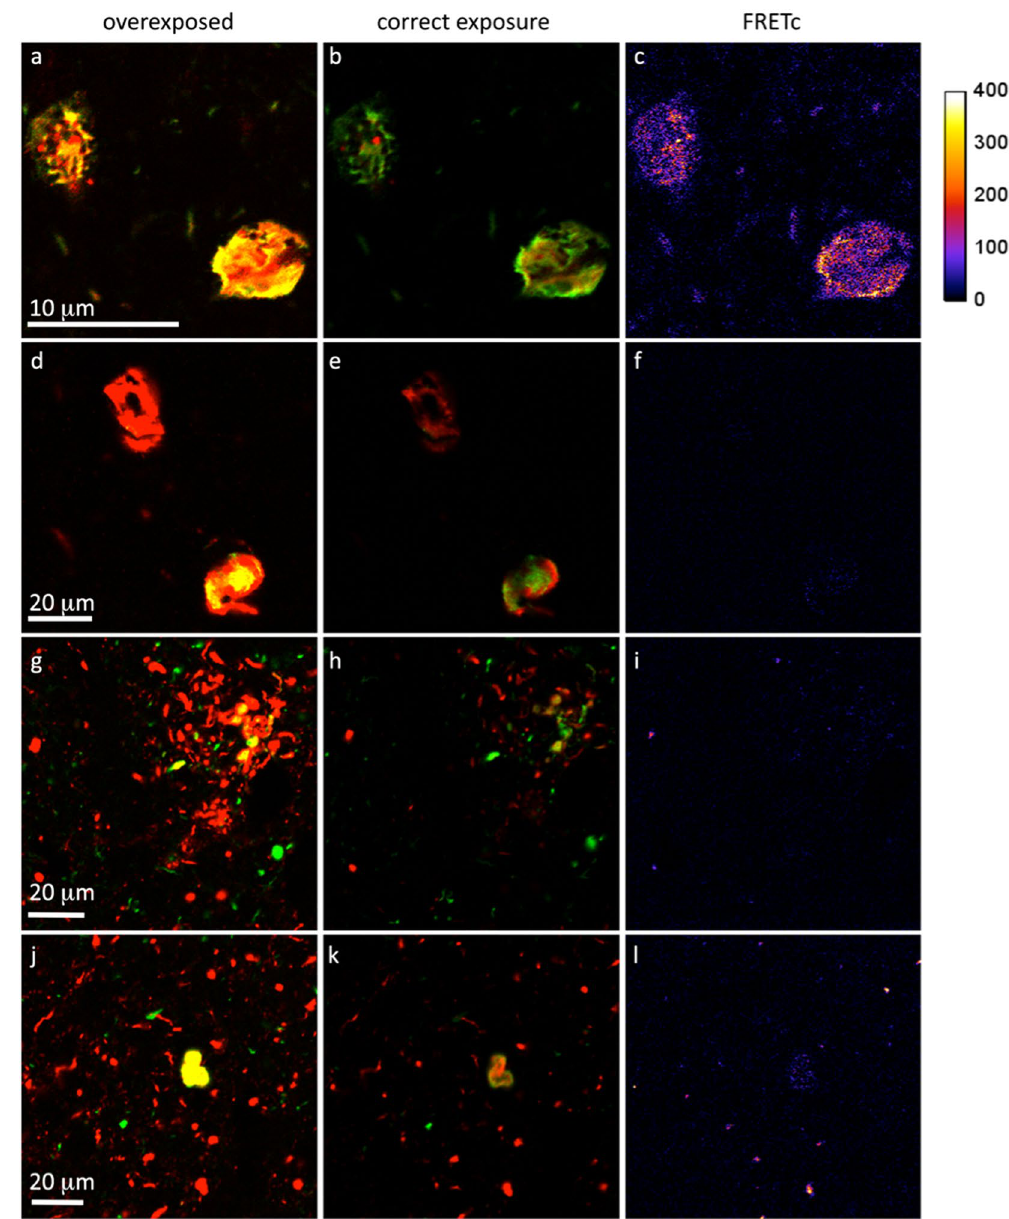
( g – l ) double-labeled α -syn and pTau. ( a , d , g , j ) over-exposed high illumination (apparent colocalization in yellow). ( b , e , h , k ) correct illumination without over-exposure. ( c , f , i , l ) corrected FRET (FRETc), x10 amplified in pseudo-color representation. A gradient color bar at the right indicates the numeric FRETc values for the different